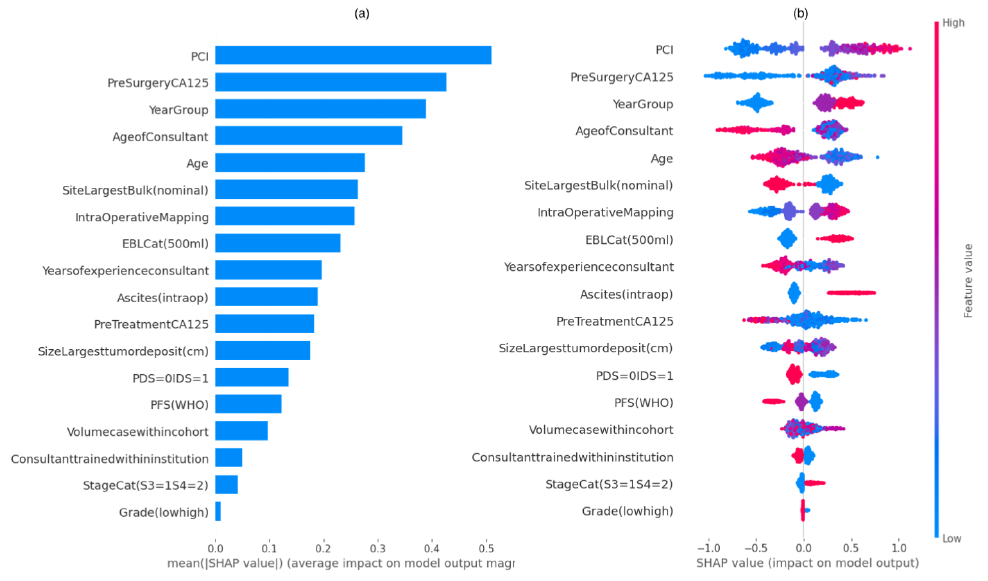
Figure 2. ( a ) Feature importance bar plot description of SHAP values (left) and ( b ) summary plot showing a set of beeswarm plots of feature distribution for global explainability of threshold SCS prediction (right). Dots correspond to the individual EOC patients. SCS, surgical complexity score; EOC, epithelial ovarian